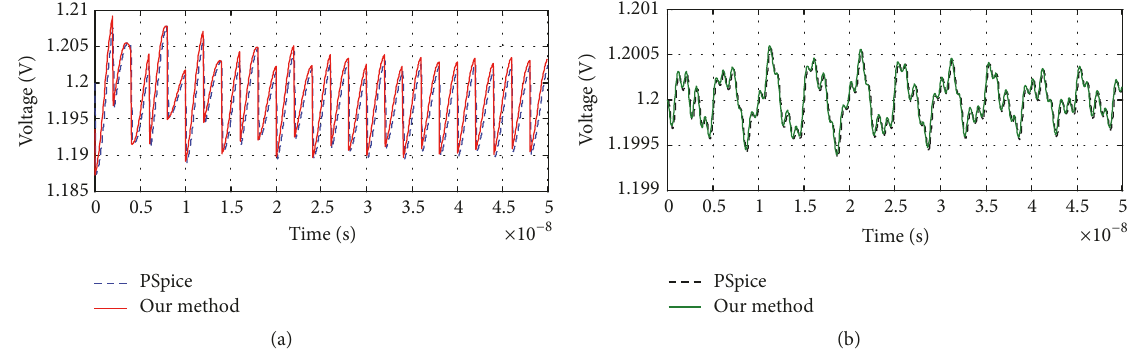
Figure 11: The frequency domain noise of the PDN for 𝐶 core.